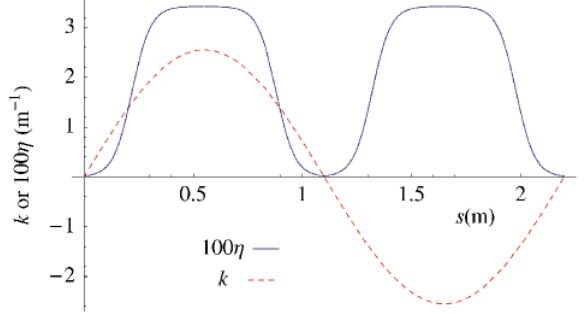
FIG. 2. (Color) The functions k (cid:2) s (cid:3) and h (cid:2) s (cid:3) , over one period.